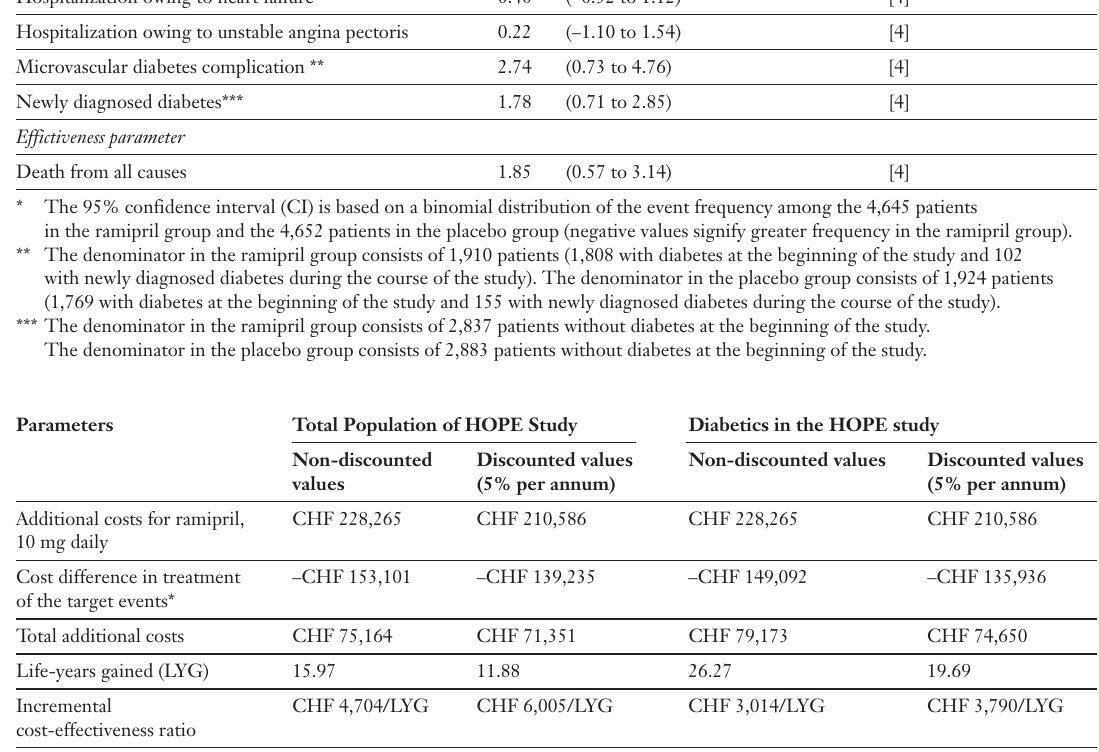
of ramipril: Number of prevented events in a hypothetical co- hort of 100 patients according to the HOPE study.